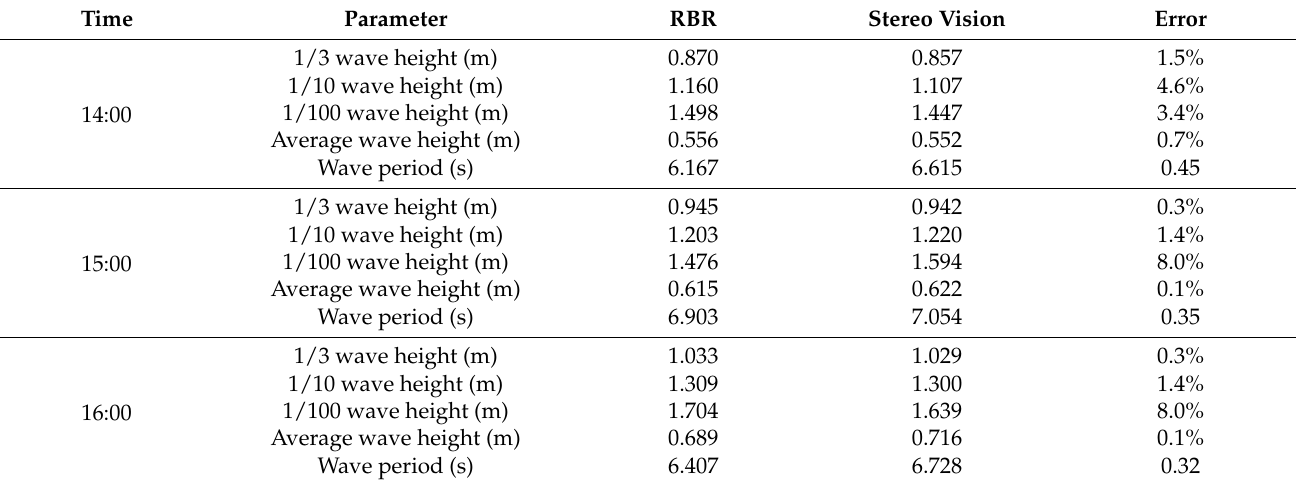
Table 6. Measurement accuracy verification.